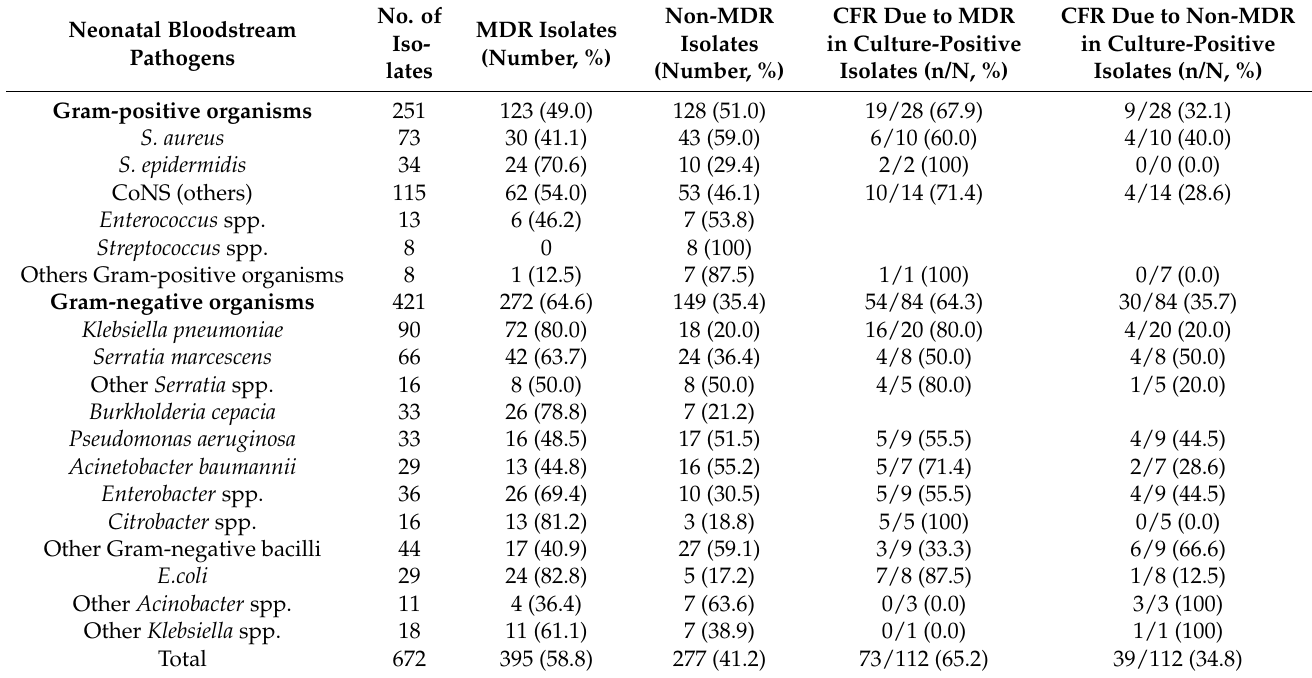
Table 6. Multidrug-resistance and case-fatality rate (CFR) of bacterial isolates from neonatal septicemia admitted to the NICU of two tertiary care hospitals in Yangon, Myanmar, January 2017 to December